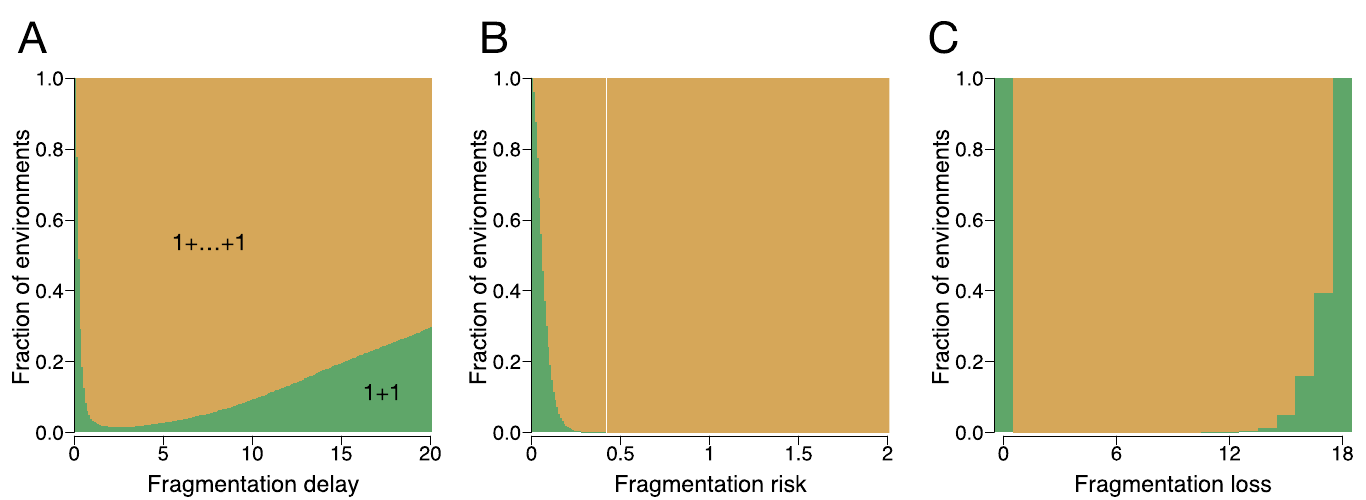
Fig 5. Multicellular units can evolve in detrimental environments. Each panel presents the fraction of the minimal, binary life cycle 1+1 (green) and equal split life cycles with a larger maturity size (orange) for random detrimental environments, where division rates decrease and death rates increase with cluster size. Panel ( A ) shows fragmentation with delay, ( B )—fragmentation with risk, and ( C )—fragmentation with cell loss. The increase in fragmentation costs, drives the evolution of life cycles involving formation of multicellular units. All evolutionarily optimal life cycles found have the form 1+ ... + 1.